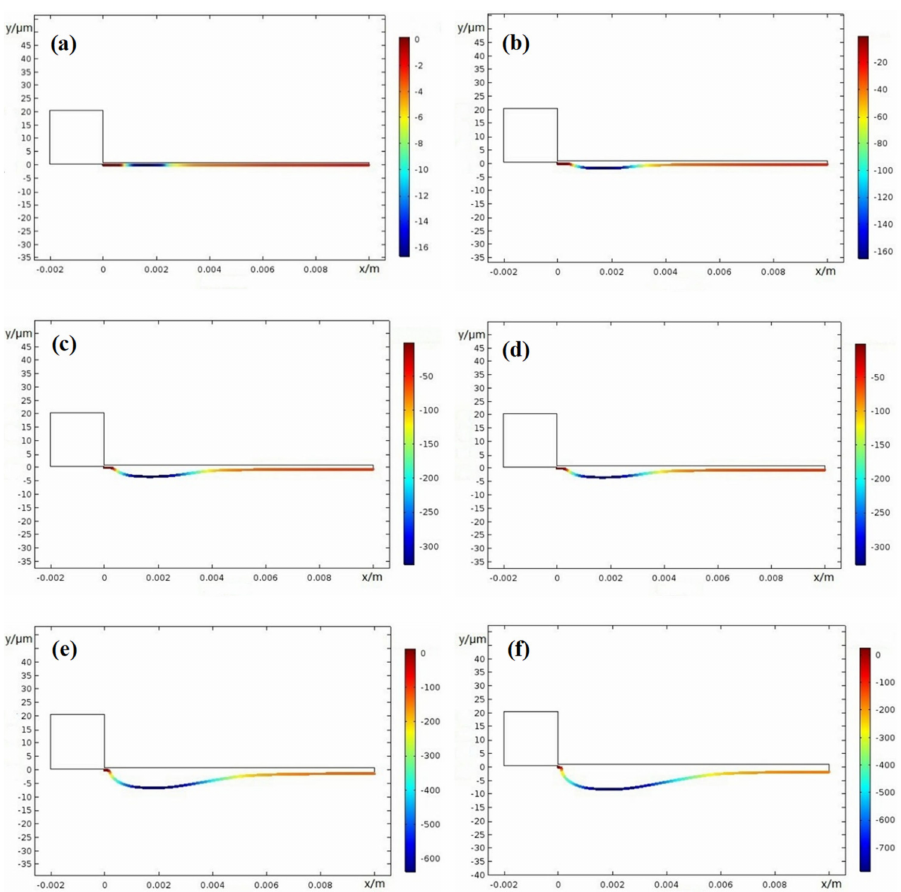
Figure 15. Damage evolution of X100 crevice corrosion at width W = 0.1 mm: ( a ) 0 weeks; ( b ) 10 weeks; ( c ) 20 weeks; ( d ) 30 weeks; ( e ) 40 weeks; ( f ) 50